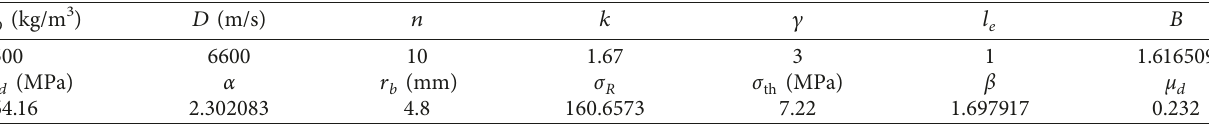
Table 7: The values of parameters plugged into the